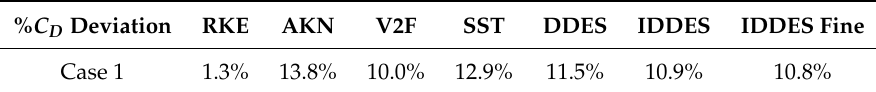
Table 1. Percent deviation of C D predictions from the experimental data for the baseline vehicle model. RKE, Realizable k − ε ; AKN, Abe–Kondoh–Nagano; IDDES, Improved Delayed Detached Eddy